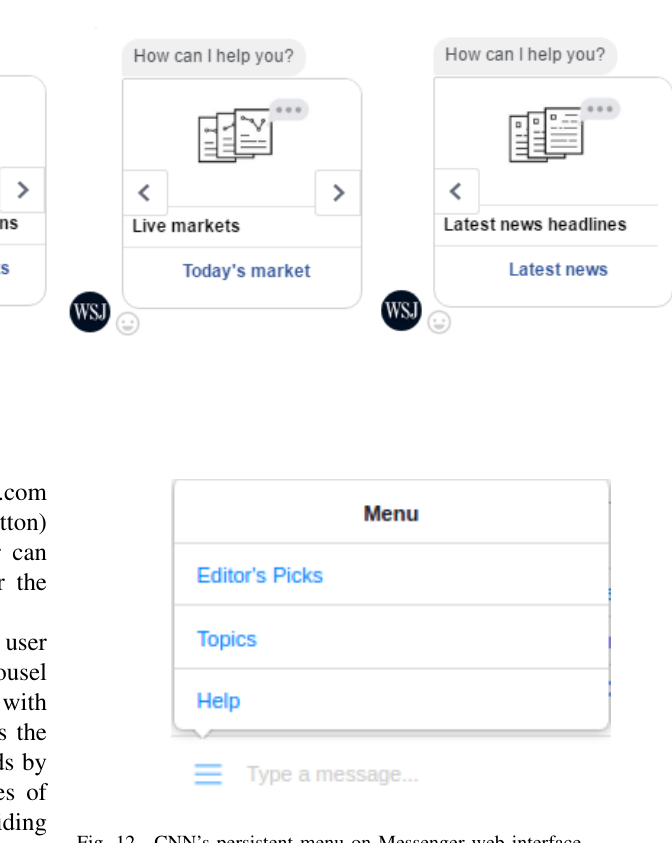
Fig. 12. CNN’s persistent menu on Messenger web